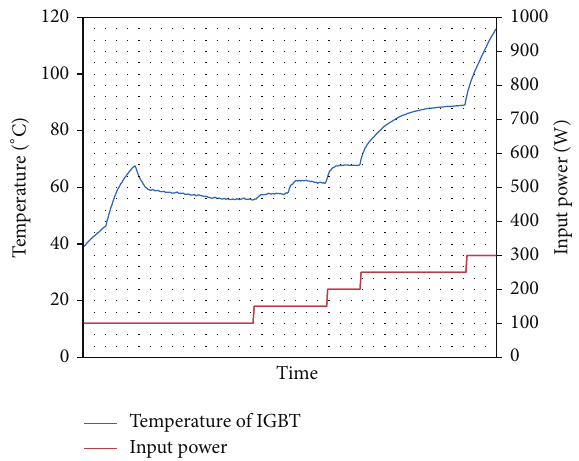
Figure 9: Dependence of temperature on input power of IGBT cooled by LHP with second variant of wick structure.